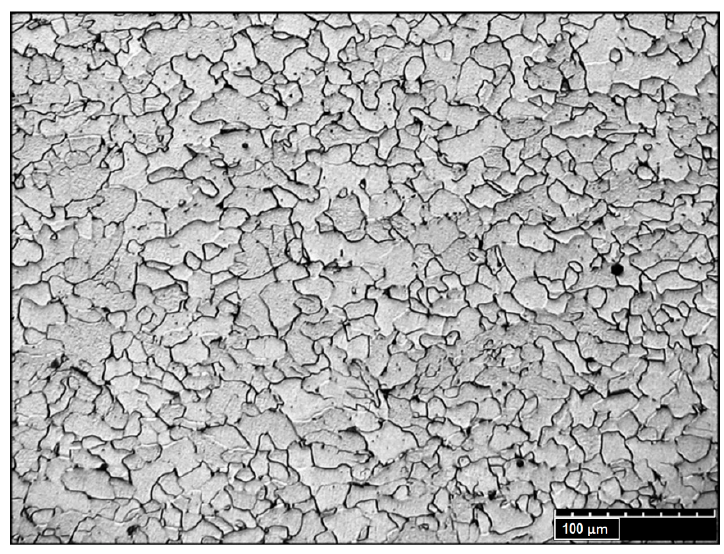
Figure 13. Microstructure of BM.